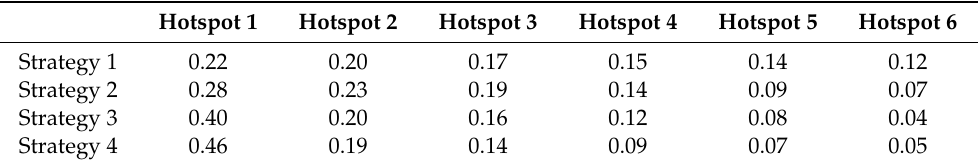
Table 1. The estimated preference rates of the historical